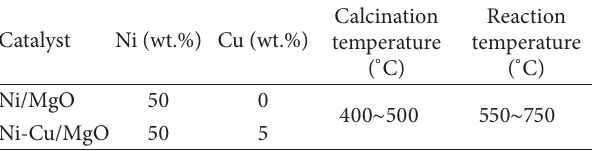
Table 1: Prepared conditions of the catalysts. Catalyst Ni (wt.%) Cu (wt.%)